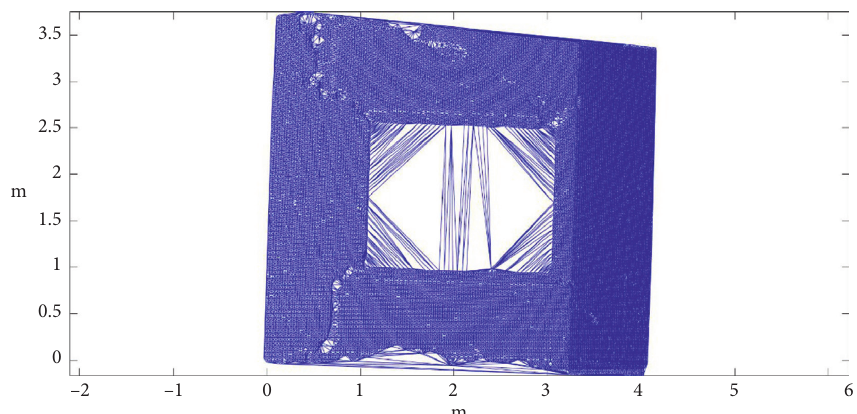
Figure 11: Distribution map of triangular network on brick and concrete construction